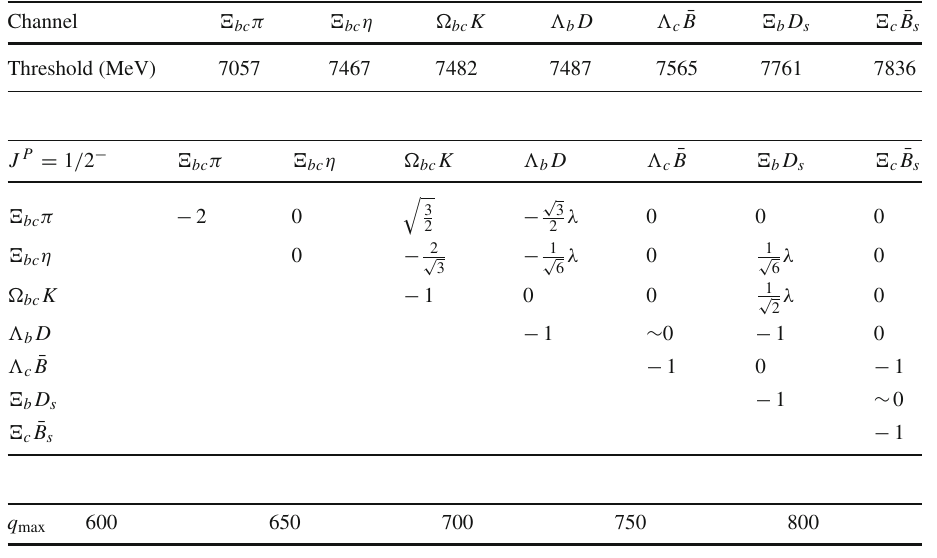
pesudoscalar-baryon (1/2) (MA) states (all units are in MeV)